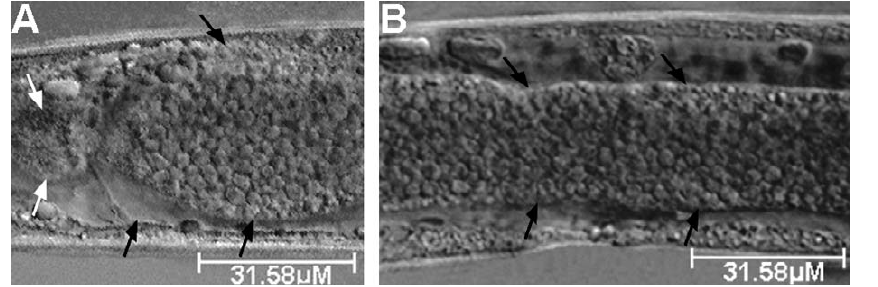
Figure 2. Intact C. albicans Cells Persist within the C. elegans Intestine C. elegans strain glp-4;sek-1 L4 worms were transferred from OP50 to C. albicans for 30 min and then moved to Candida -free liquid media for 6 d when the worms were photographed. Intact yeast cells are seen within the (A) proximal and (B) distal intestine. White arrows in (A) point to the pharyngeal grinder organ. Black arrows point to the intestinal lumen. Scale bars are 31.58 l m.